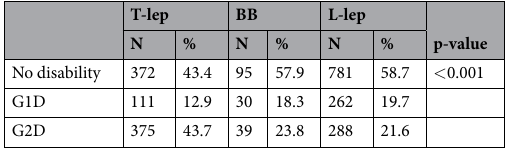
Table 2. Relationship between clinical types and